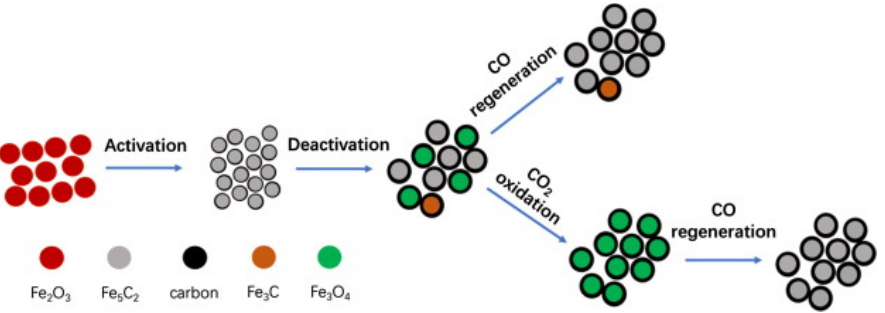
Figure 6. Transformation of iron phases during the life cycle of the catalyst tested in the selective olefin formation reaction from CO 2 . Reproduced from Ref. [41] with copyright license from Elsevier (2021).